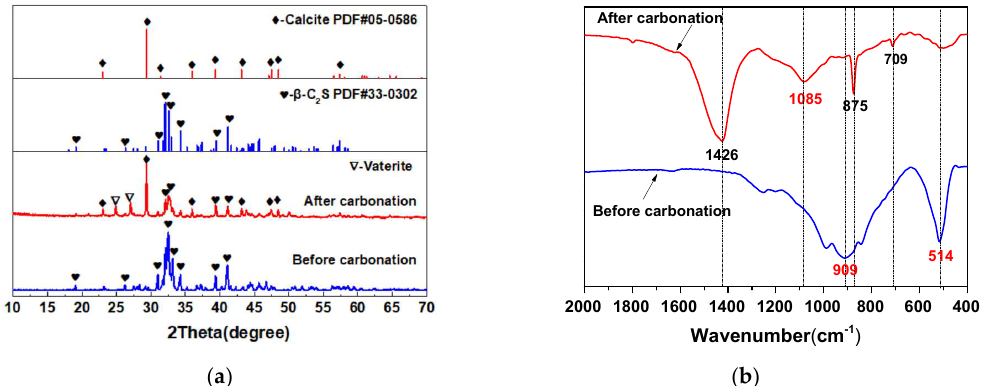
Figure 1. X-ray diffraction and Fourier transform-infrared spectra of β-C 2 S before and after Figure 1. X-ray di ff raction and Fourier transform-infrared spectra of β -C 2 S before and after carbonation. carbonation. ( a ) XRD; ( b ) FT-IR. ( a ) XRD; ( b )